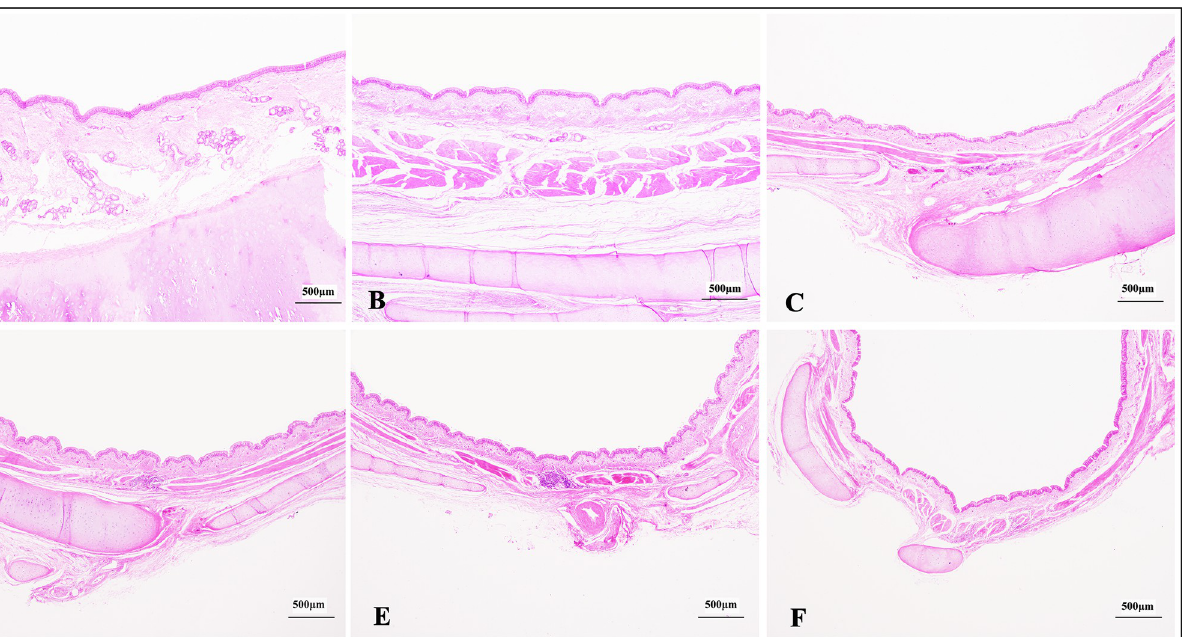
PLOS ONE | https://doi.org/10.1371/journal.pone.0264815 March 4,